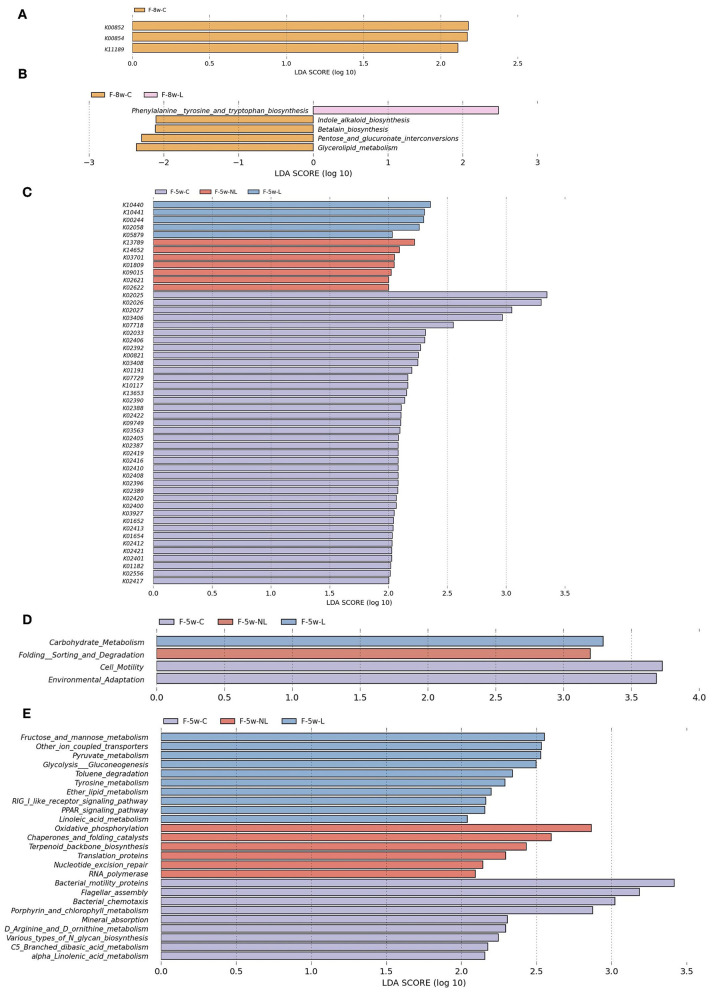
Functional predictions for the intestinal microbiome of the ligation group, the non-surgical periodontal treatment group and the control group at 5weeks and 8weeks. The KOs with significantly different abundances at 5 weeks (C) and 8 weeks (A) are shown. (D) Significant KEGG pathways at level 2 at 5 weeks. Significant KEGG pathways at level 3 at 5 weeks (E) and 8 weeks (B). The LDA scores (log10)>2 and P < 0.05 are listed. F-5w-C, control group; F-5w-NL, non-surgical periodontal treatment group; F-5w-L, ligation group; F-8w-C, control group; F-8w-NL, non-surgical periodontal treatment group; F-8w-L, ligation group; KO, KEGG orthologs.